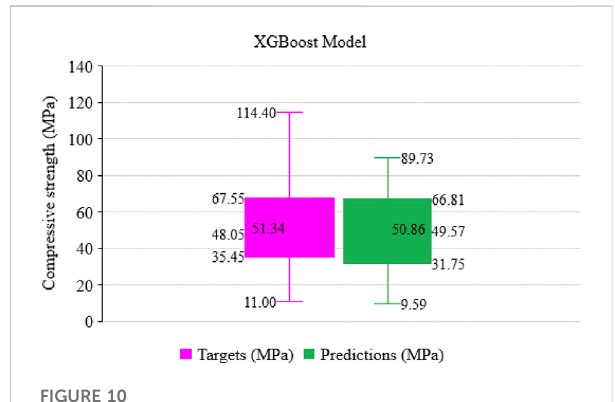
FIGURE 10 Box plot for actual and XGBoost predicted results.